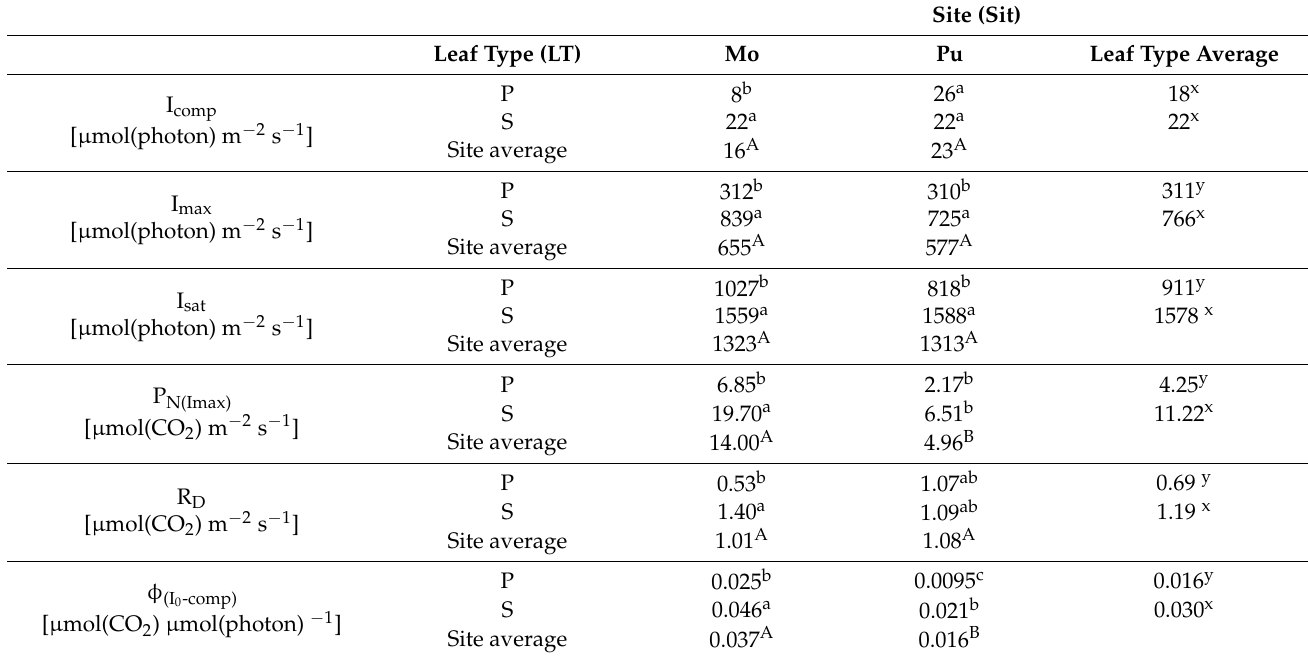
Table 1. Leaf-level photosynthetic parameters of different leaf types (P: petiolate; S: sessile) of Salvia ceratophylloides individuals of two sites (Mosorrofa, Mo; Puzzi, Pu) estimated by non-linear regression using the Ye et al. model [28]. Different lower-case letters represent significant differences at p < 0.05 among the average within the column (Tukey’s test). Different capital case letters represent statistically significant differences among the means along the rows ( p < 0.05, Tukey’s test).